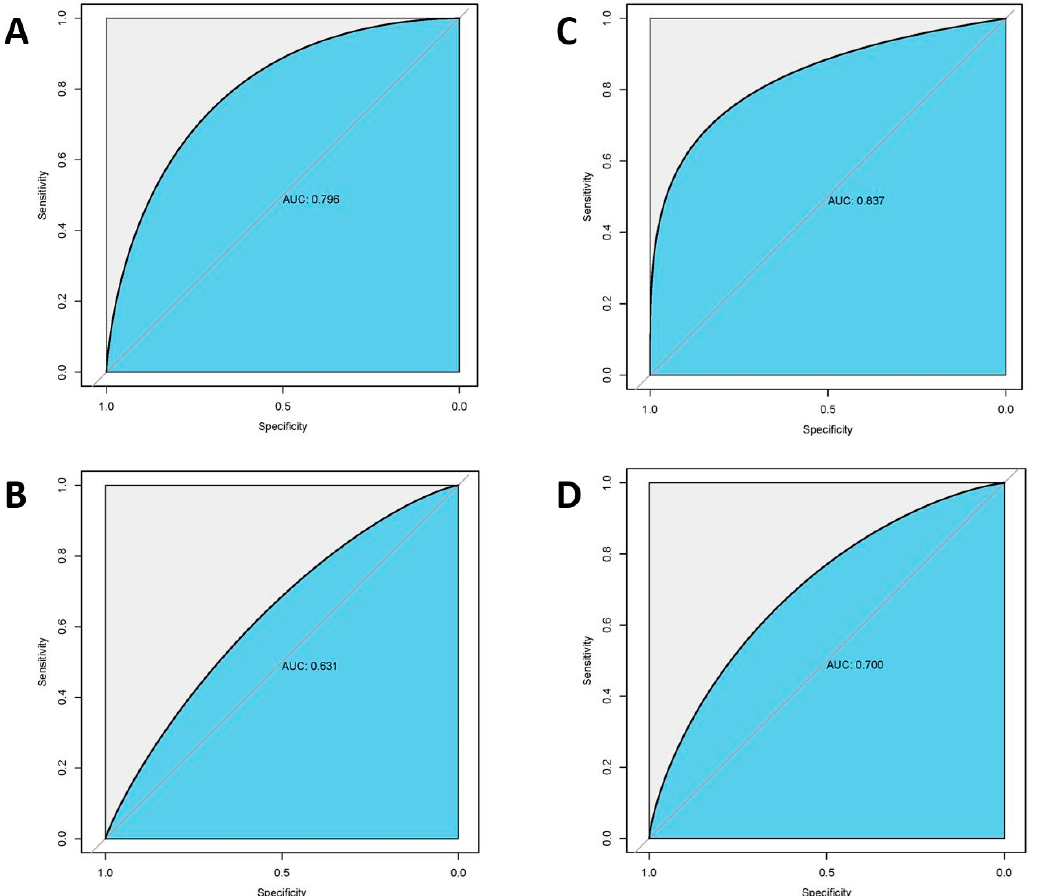
Figure 5. Receiver operating characteristic curves of Lasso+ LDA machine learning models. ( A ): In- ternal test ( n = 62) of radiomic model; ( B ): External test ( n = 61) of radiomic model; ( C ): Internal test ( n = 62) of clinical radiological–radiomic-based model; ( D ): External test ( n = 61) of clinical radiolog- ical–radiomic-based model; AUC : Area under Curve.